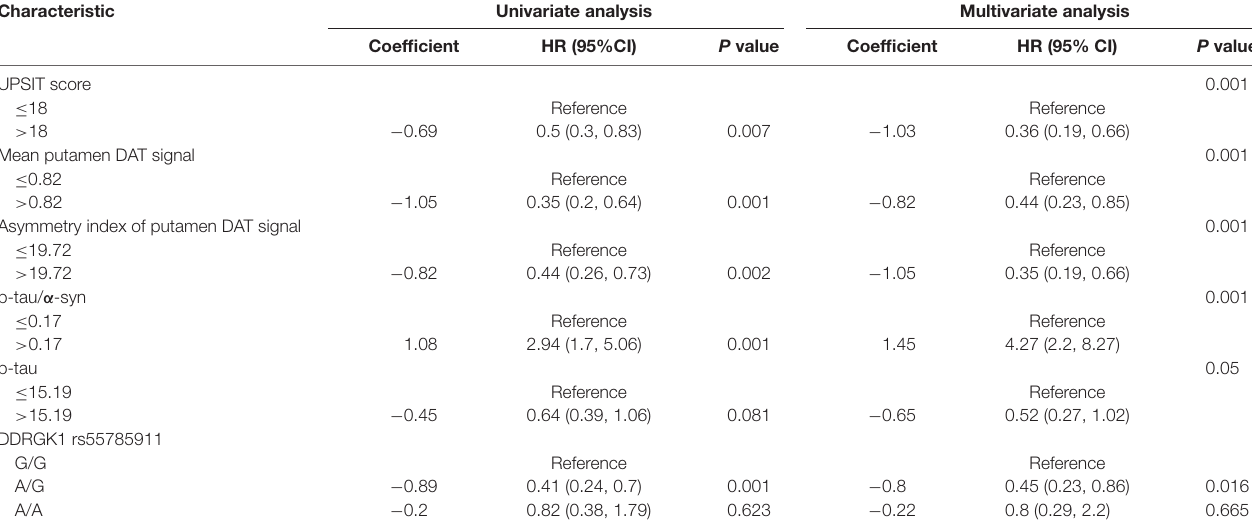
TABLE 2 | Univariate and multivariate Cox regression analysis based on predictors of MCI in model 1.